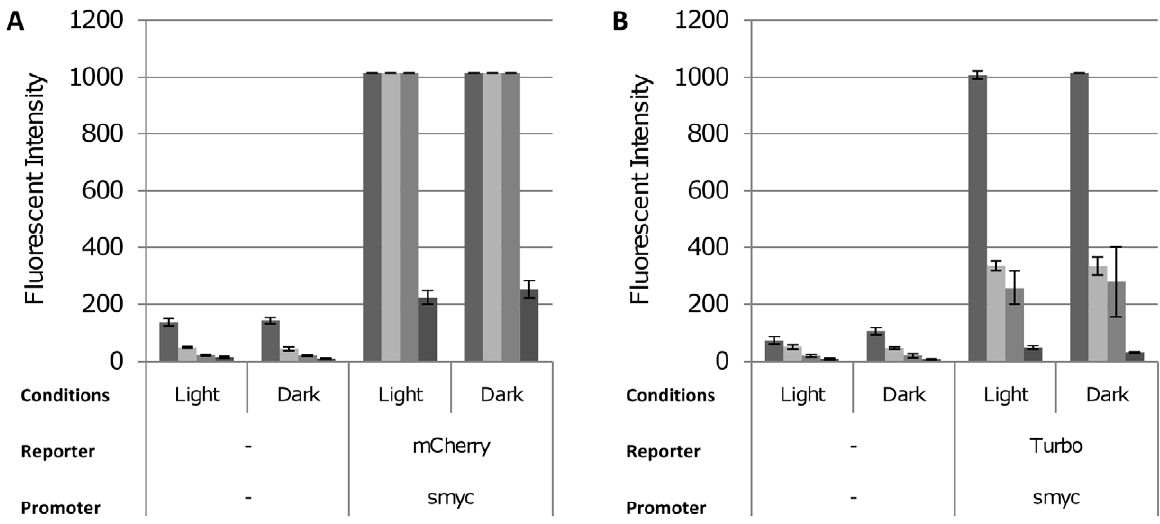
Figure 5. Far-red fluorescent reporters are functional in M.marinum strain M. Fluorescent reporters were expressed from P smyc in M. marinum and assayed in liquid culture grown either in the dark or in the light. Cultures were diluted (from left to right) to an OD 580 of 0.25, 0.10, 0.05 and 0.01, representing cell densities of 9.8 6 10 5 , 4.2 6 10 5 , 1.9 6 10 5 and 6.5 6 10 4 CFU/ml respectively. Fluorescence was quantified at the following wavelengths: mCherry 587/610 nm, Turbo-635 588/635 nm. Data are the mean and standard deviation from three independent transformants. A value of 1015 corresponds to saturation of the machine. The reporter and promoter backbone are indicated.